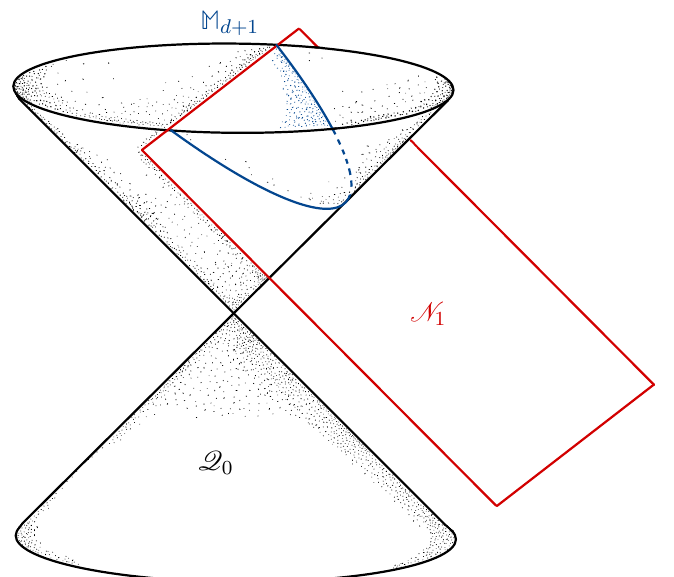
Figure 2 . An embedding of ( d + 1) -dimensional Minkowski spacetime M d +1 as the intersection Q N in the ambient space E d +1 , 2 0 ∩ 1